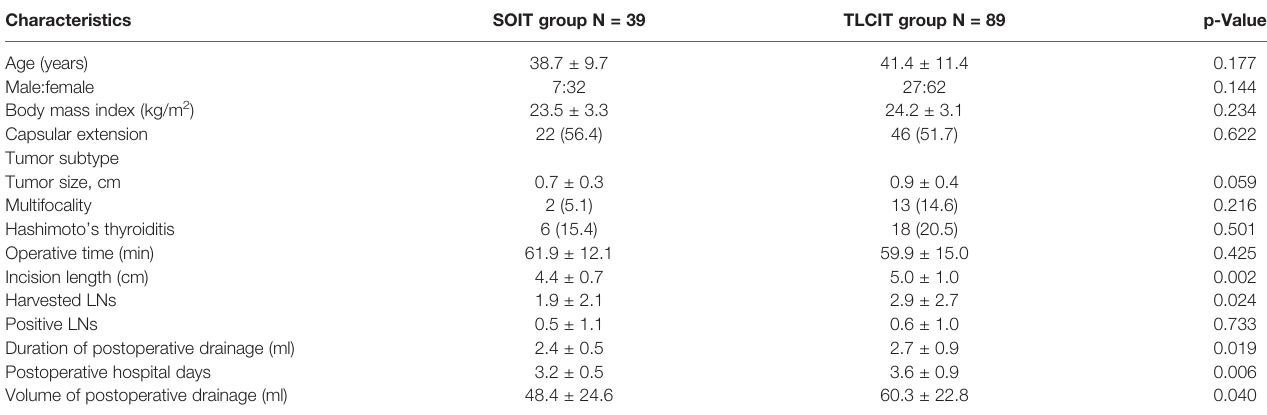
LNs, lymph nodes; SOIT, supraclavicular oblique incision thyroidectomy; TLCIT, traditional low collar incision thyroidectomy.